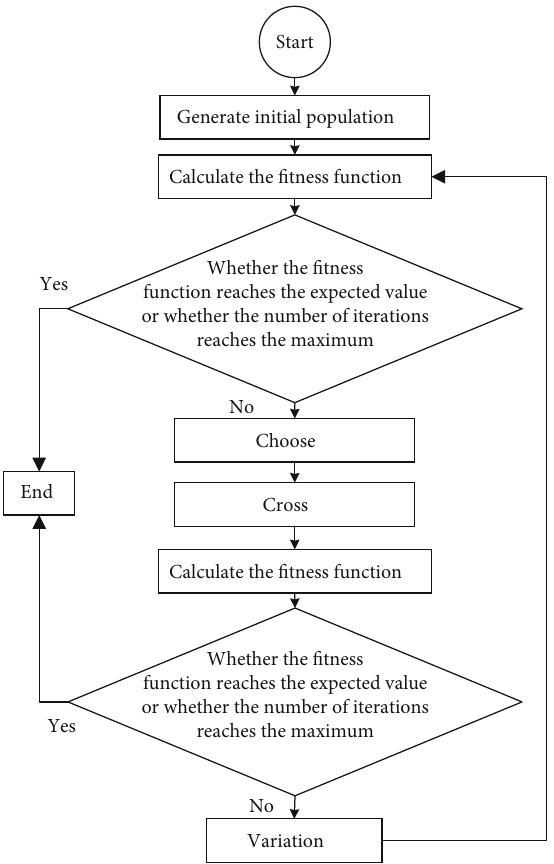
Figure 2: Schematic diagram of genetic algorithm